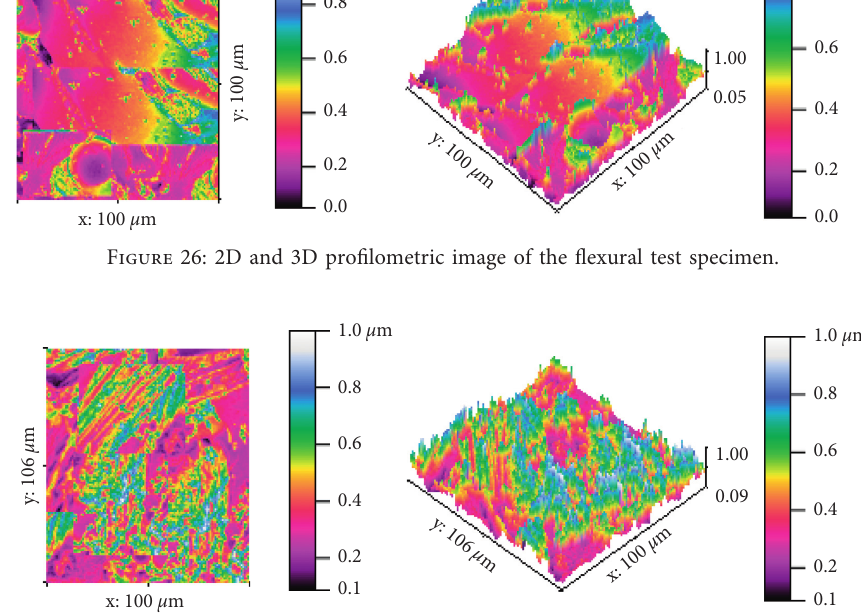
Figure 27: 2D and 3D profilometric image of the impact test